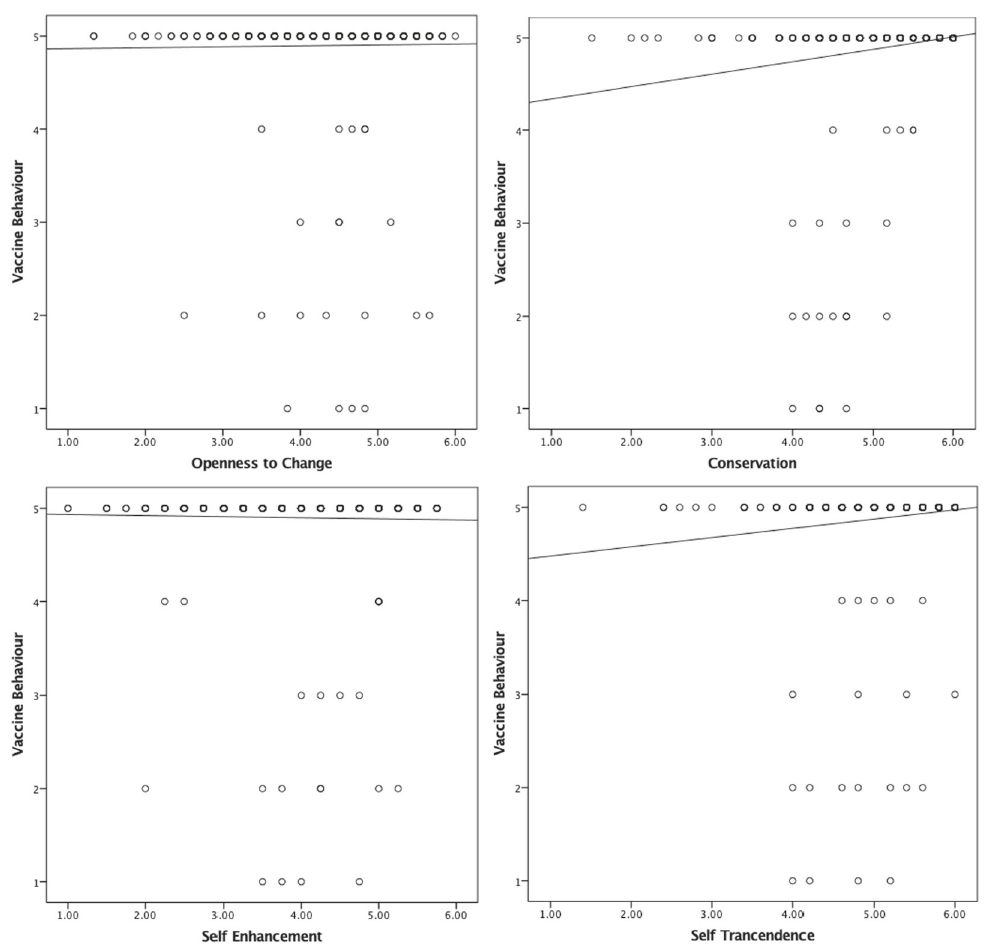
Fig. 2 Relationship between vaccine behaviour scores and higher order values scores. They show the relationshipbetween these four higher-order values and vaccine